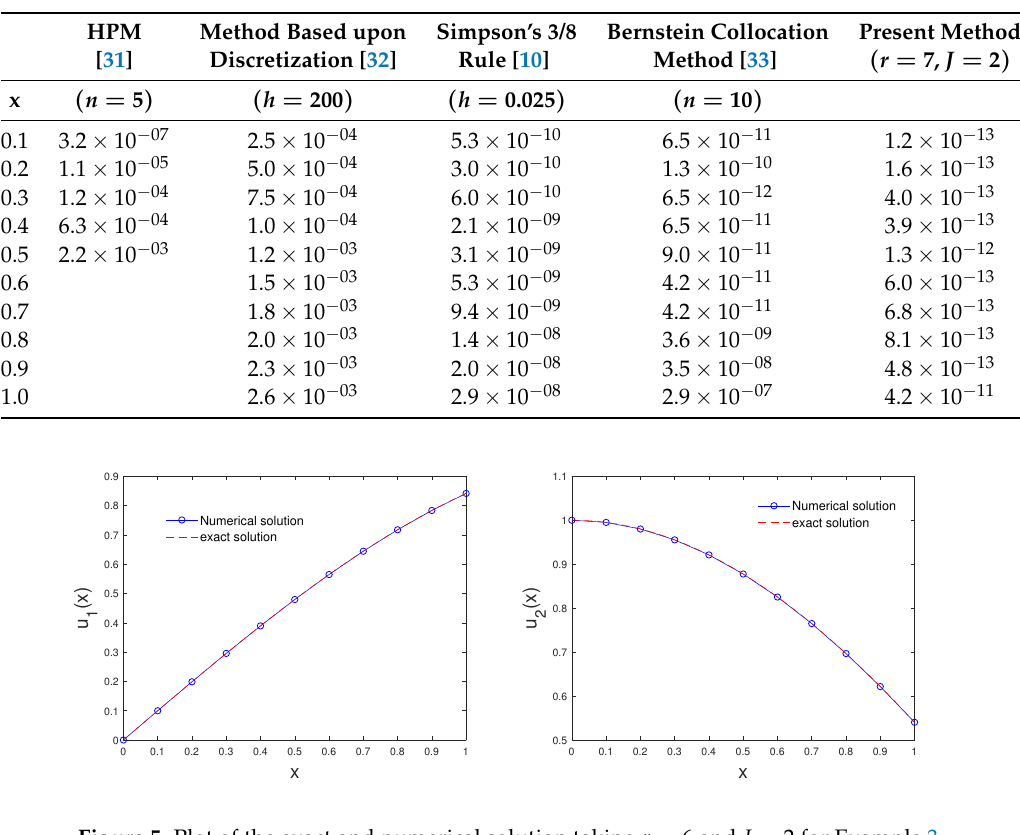
Figure 5. Plot of the exact and numerical solution taking r = 6 and J = 2 for Example